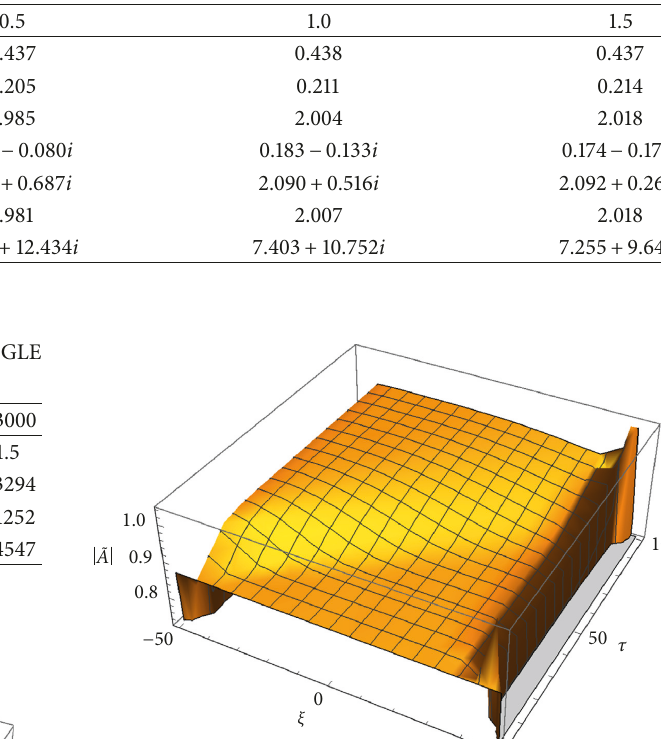
Table 1: Linear and weakly nonlinear calculations for four values of α and β � 0 . 3.